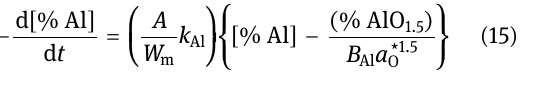
Table 1: A fi rst - order interaction parameter e ij used in the current study [ 31 – 34 ]